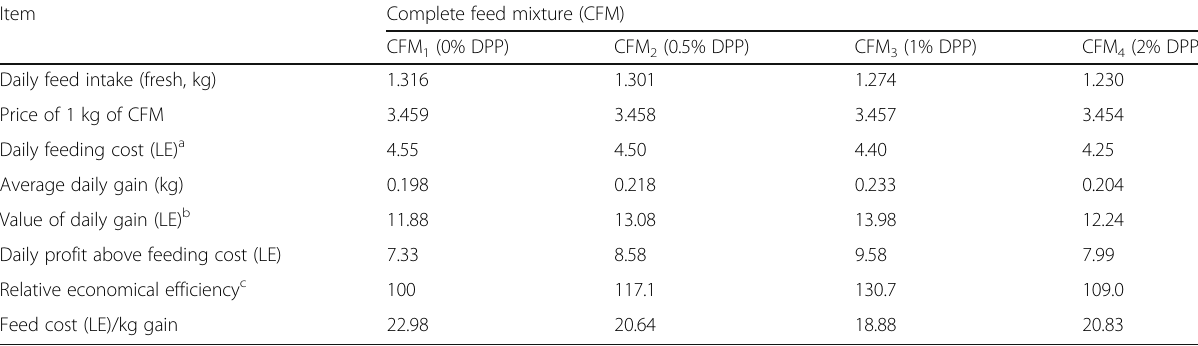
Table 9 Economic evaluation of experimental